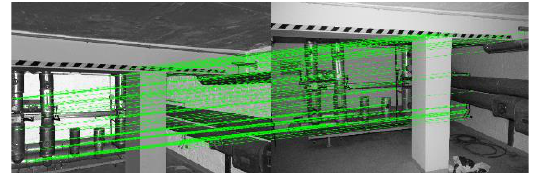
Figure 8. Feature matching after outlier